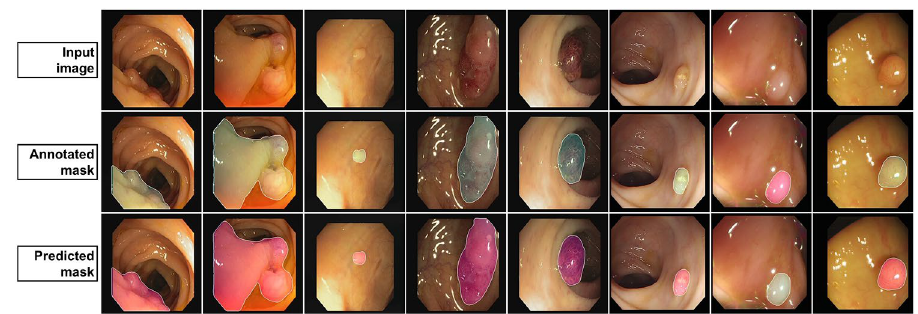
Figure 7. Sample model outputs with corresponding image input and ground